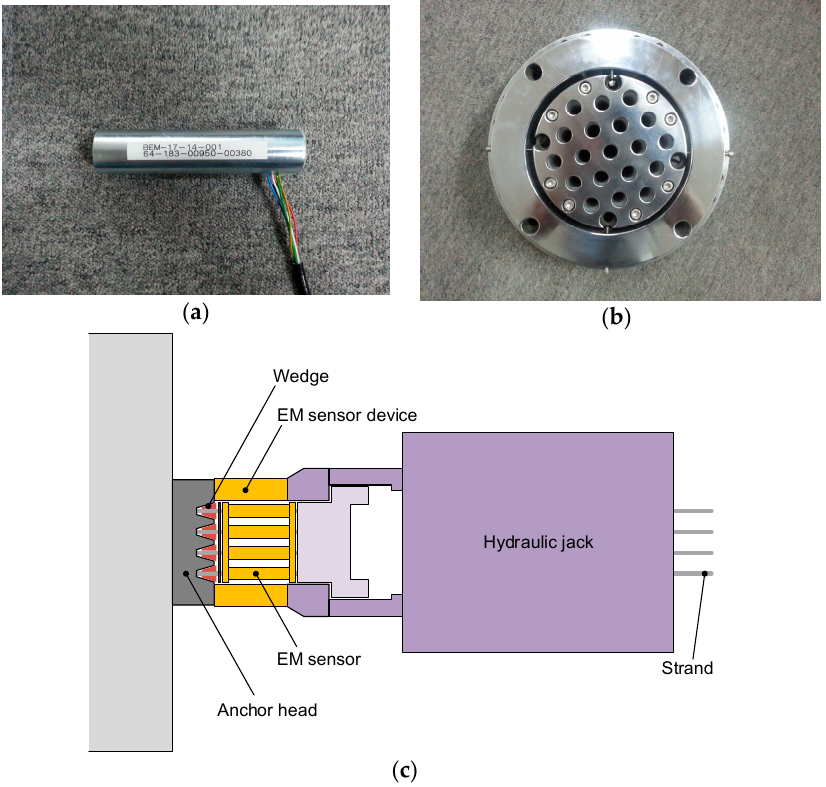
Figure 3. Developed device: ( a ) Electromagnetic (EM) sensor; ( b ) EM sensor device; ( c ) Schematic drawing of the composition of sensing device for the measurement of the prestress force distribution (EM sensor device + hydraulic jack).